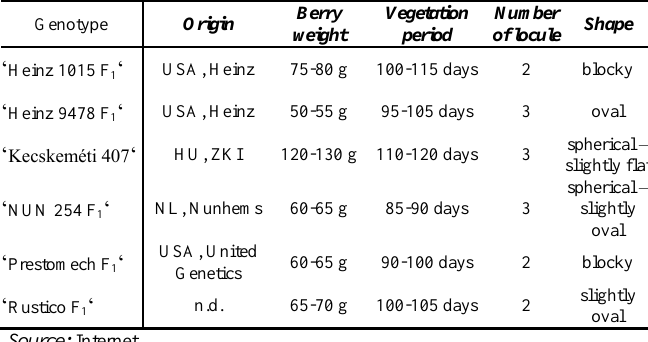
Table 1. Main characteristics of the evaluated genotypes.